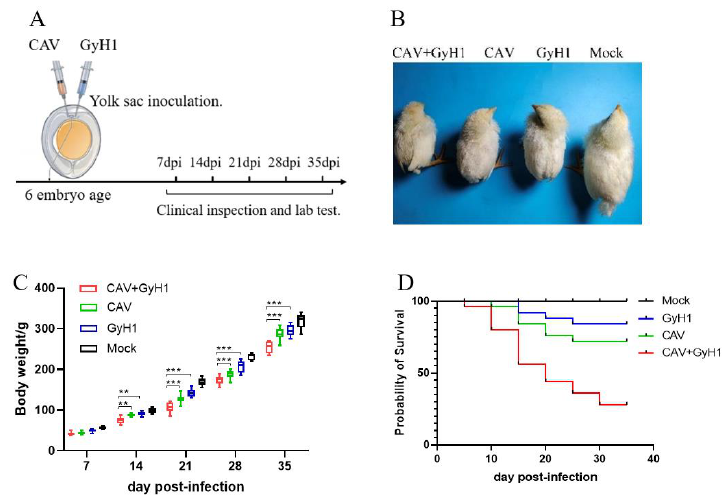
Figure 1. Experimental design and clinical presentation of infected chickens. ( A ) Schematic diagram of experimental infection and testing. Relevant data detection is performed at specified time points. ( B ) Clinical observation of chicken in each group. ( C ) Dynamic changes of weight gain of chickens in four groups. ( D ) Survival curve. **, p < 0.01; ***, p < 0.001, (Student’s t